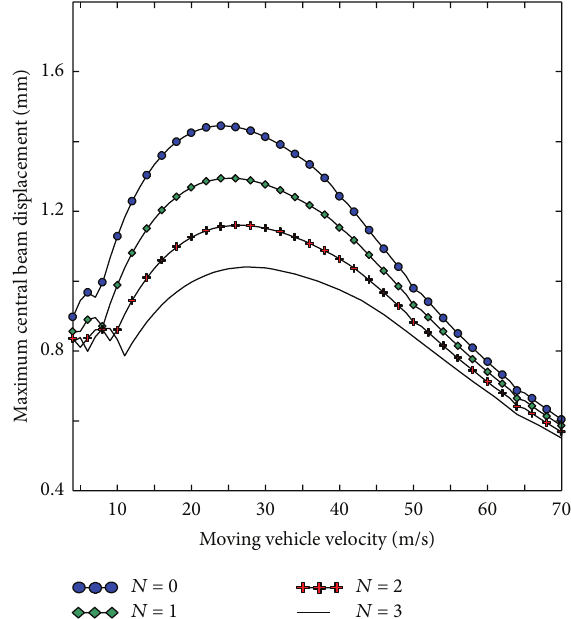
Figure 5: The maximum displacement of the beam at mid-span versus the velocity of the moving load for 𝜁 = 0.15 .